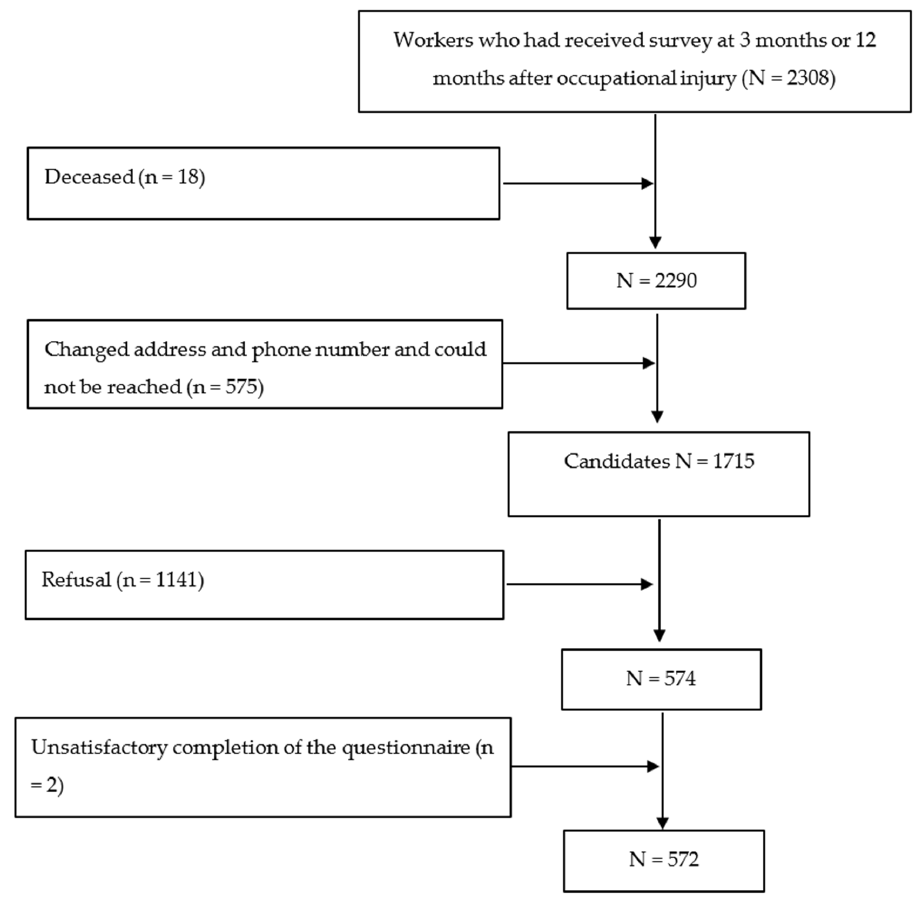
Figure 1. Study population recruitment.